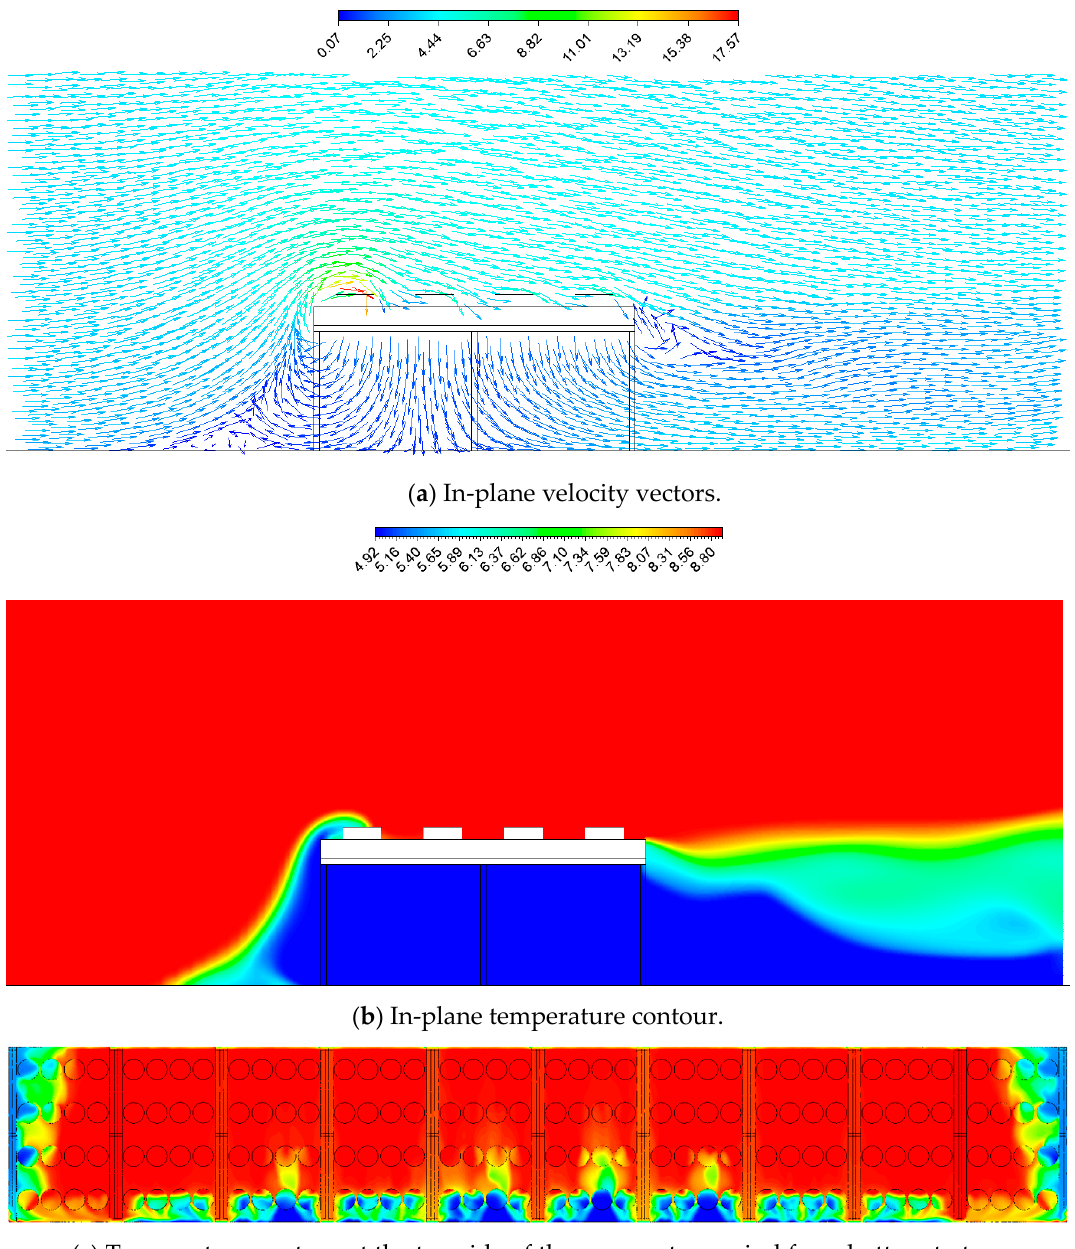
Figure 11. Velocity vectors ( a ) and temperature contour ( b ) at the cross-section of row 21 and temperature contour at the top side of the evaporators ( c ), uniform field and east wind condition.